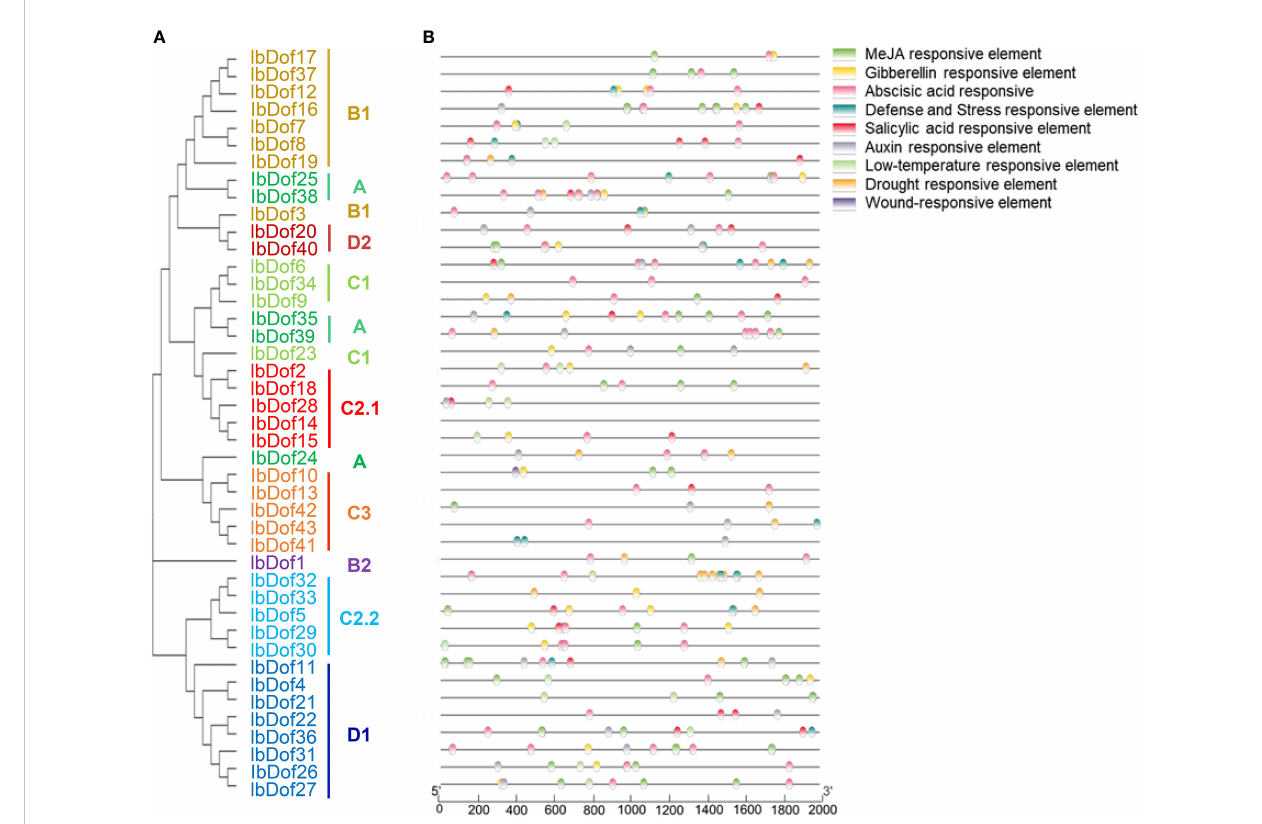
FIGURE 7 Phylogenetic clustering and predicted stress- and hormone-related cis-elements in the promoters of IbDof genes. (A) The phylogenetic tree of 43 IbDofs was constructed by MEGA X based on the consistent parameters used in Figure 2. (B) Predicted cis-elements in the IbDof promoters. 2000 bp promoter regions of each IbDof gene were detected by PlantCARE database. Different colored rectangles represent different cis-elements that are potentially involved in stress or hormone